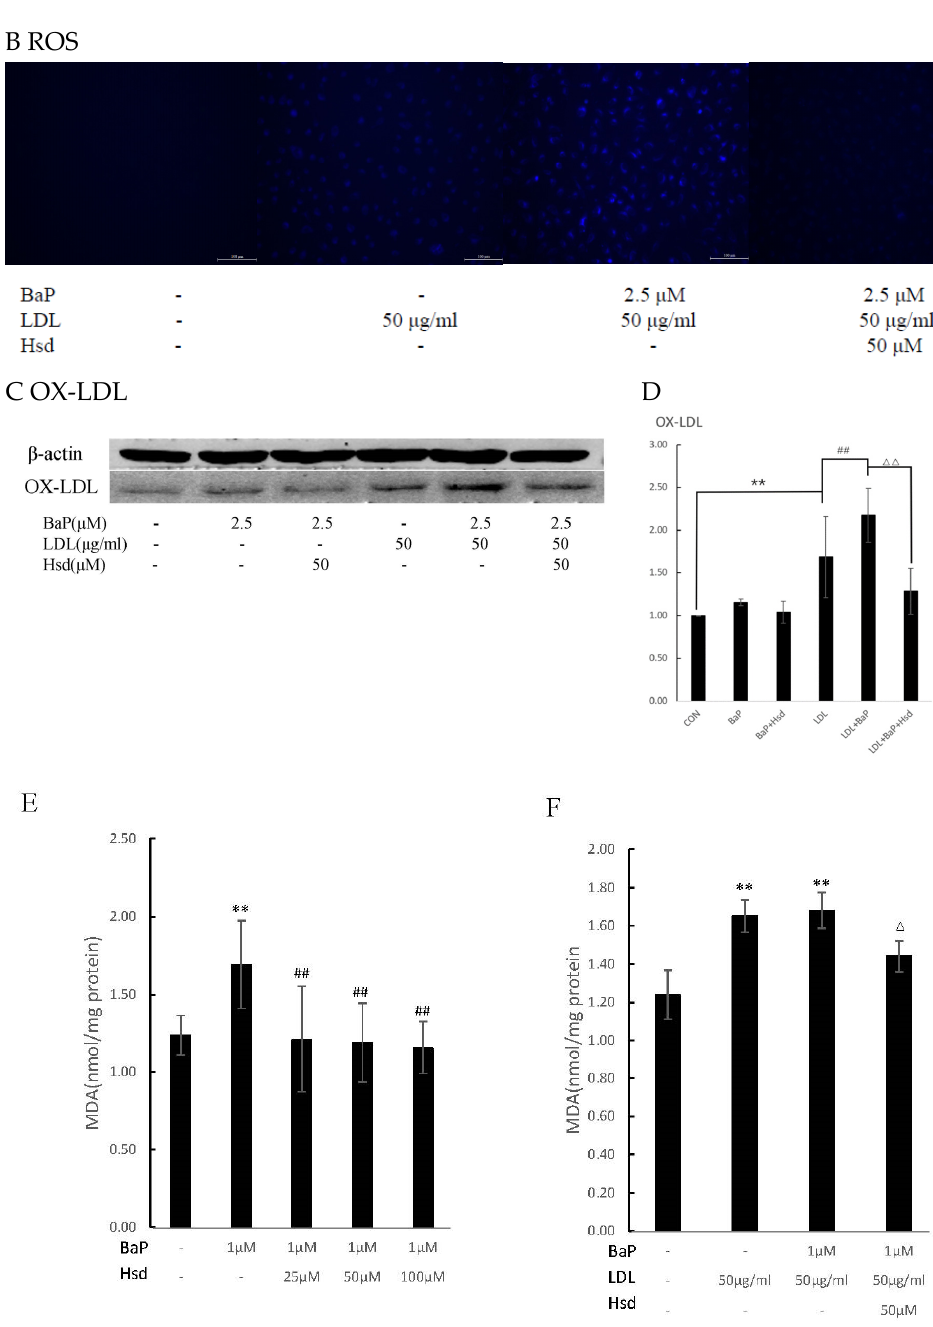
Figure 2. Antioxidant effect of Hesperidin in mediating oxidation in EA.hy926 induced by BaP. ( A ) Effects of Hsd with different concentrations on reactive oxygen species (ROS) production induced by BaP in EA.hy926 ( n = 3 per group, Scale bars, 100 µ m). ( B ) Effect of Hsd on ROS production induced by BaP at high LDL concentrations in EA.hy926 ( n = 3 per group, Scale bars, 100 µ m). ( C ) Representative Western blot of oxidized low-density lipoprotein (OXLDL) levels in the EA.hy926 cells extracts. ( D ) Quantification of OXLDL. The data was presented as means ± SD ( n = 4), and all experiments were performed in triplicate and analyzed using one-way ANOVA. ** p < 0.01 vs. normal control group, ## p < 0.01 vs. LDL group, ∆∆ p < 0.01 vs. BaP+ LDL group. ( E ) Effect of Hsd with different concentrations on malondialdehyde (MDA) production induced by BaP in EA.hy926. ( F ) Effect of Hsd on MDA production by BaP at high LDL concentrations in EA.hy926. The data are presented as means ± SD ( n = 3), and were analyzed using one-way ANOVA. ** p < 0.01 vs. normal control group, ## p < 0.01 vs. BaP control group, ∆ p < 0.05, ∆∆ p < 0.01, vs. BaP+ LDL